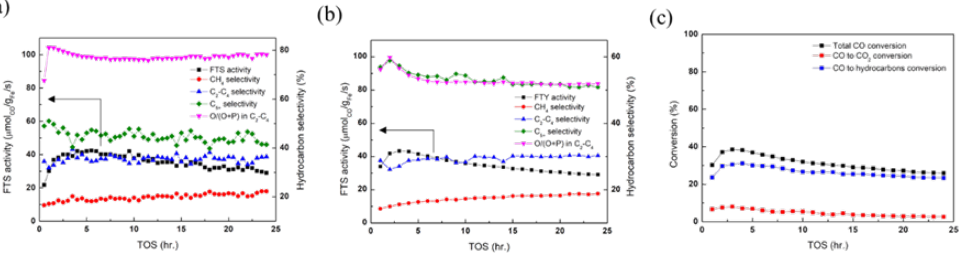
Figure 5. ( a ) The FTS reaction activity and hydrocarbon selectivity over the χ -Fe 5 C 2 @SiO 2 _L catalyst during the 24 h time on stream; ( b ) the FTS reaction activity and hydrocarbon selectivity over the χ -Fe 5 C 2 @SiO 2 _H catalyst during the 24 h time on stream; ( c ) CO conversions to hydrocarbons and CO 2 of the χ -Fe 5 C 2 @SiO 2 _H catalyst, the total CO conversion is the sum of the CO to hydrocarbon conversion and the CO to CO 2 conversion. Reaction conditions: 0.3 g catalyst, 300 °C, 10 bar, H 2 /CO = 2.1, GHSV = 4000 mL gcat −1 h −1 . Table 1. CO conversion, CO 2 and hydrocarbon selectivity, and FTS activity of χ -Fe 5 C 2 @SiO 2 _L, χ - Fe 5 C 2 @SiO 2 _H, and other reference catalysts.